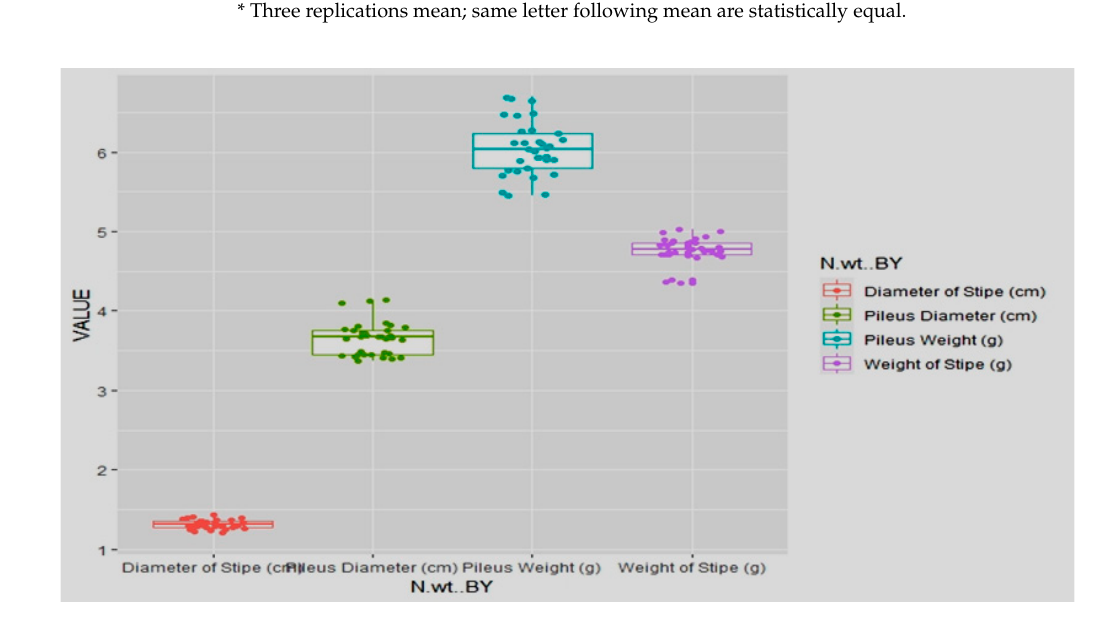
Figure 13. Boxplots for impact of systemic fungicides on T. harzianum infested casing pooled during spring 2017 and 2018 on quality parameters of A. bisporus.